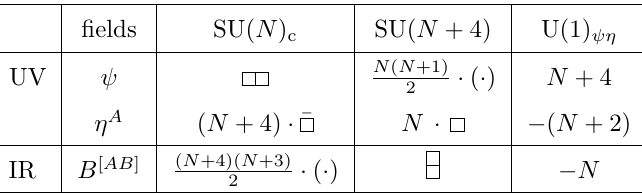
Table 1 . Chirally symmetric “confining” phase of the ψη model. As in other tables of the text, the multiplicity, charges and the representation are shown for each set of fermions. ( · ) stands for a singlet